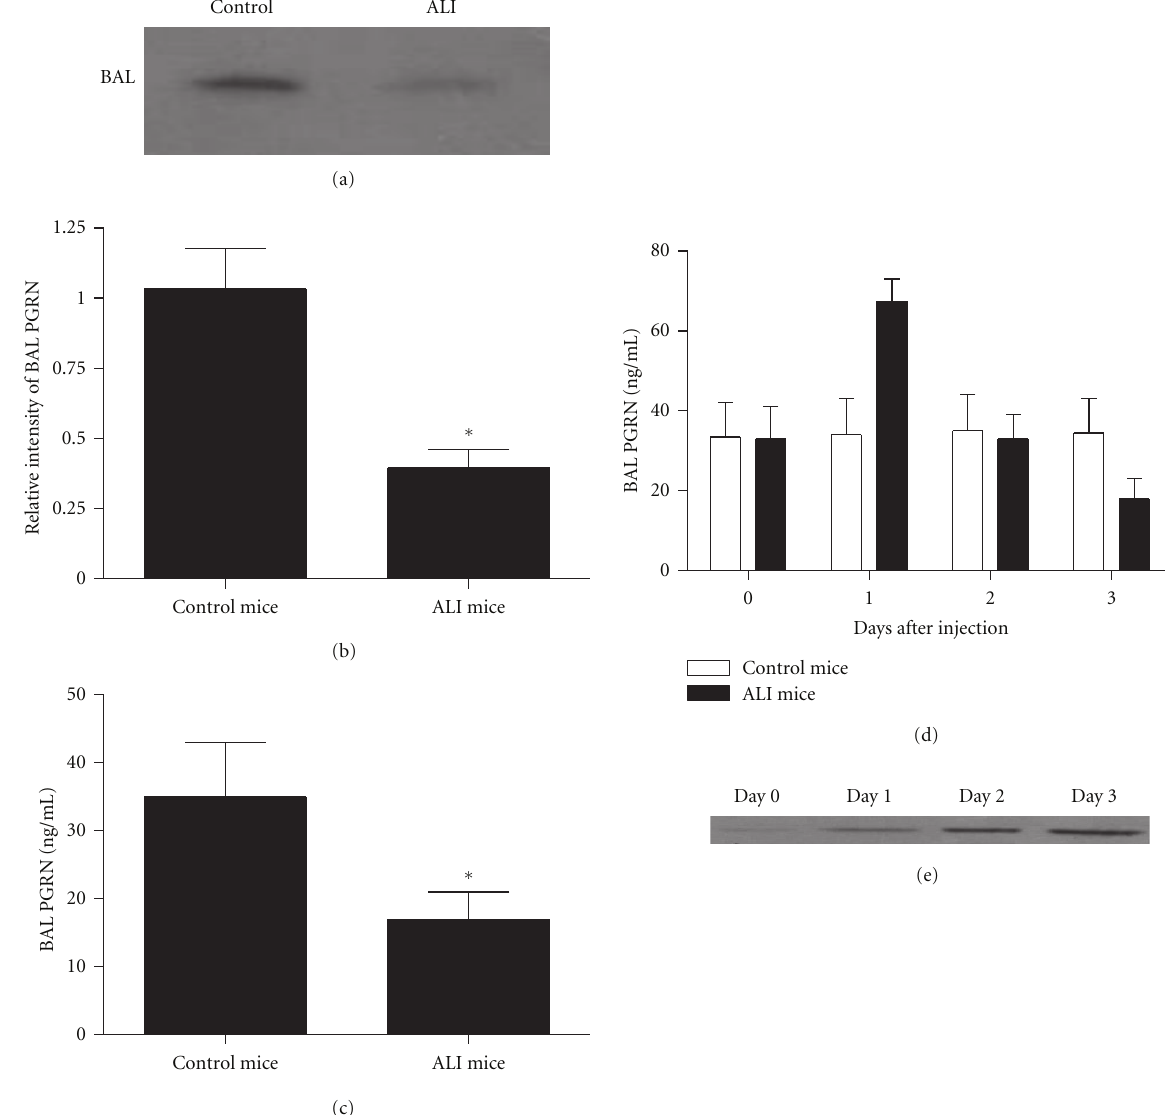
Figure 1: PGRN was downregulated in BAL fluid of LPS-induced ALI mice. Groups of mice were challenged with LPS for 3 days. (a) The level of PGRN in BAL fluid in LPS-induced ALI mice or control mice was determined using western blot on day 3. (b) A histogram of the relative amounts of PGRN in BAL fluid from three individual experiments was shown. (c) The level of PGRN in BAL fluid in LPS-induced ALI mice or control mice was determined using ELISA on day 3. (d) The level of PGRN in BAL fluid in LPS-induced ALI mice or control mice was determined using ELISA at the indicated time. (e) The expression of granulin in BAL fluid in LPS-induced ALI mice was detected using western blot at the indicated time. Data are represented as mean ± standard deviation of one experiment consisting of three replicates. Experiments were performed in triplicate. ∗ P < 0 .